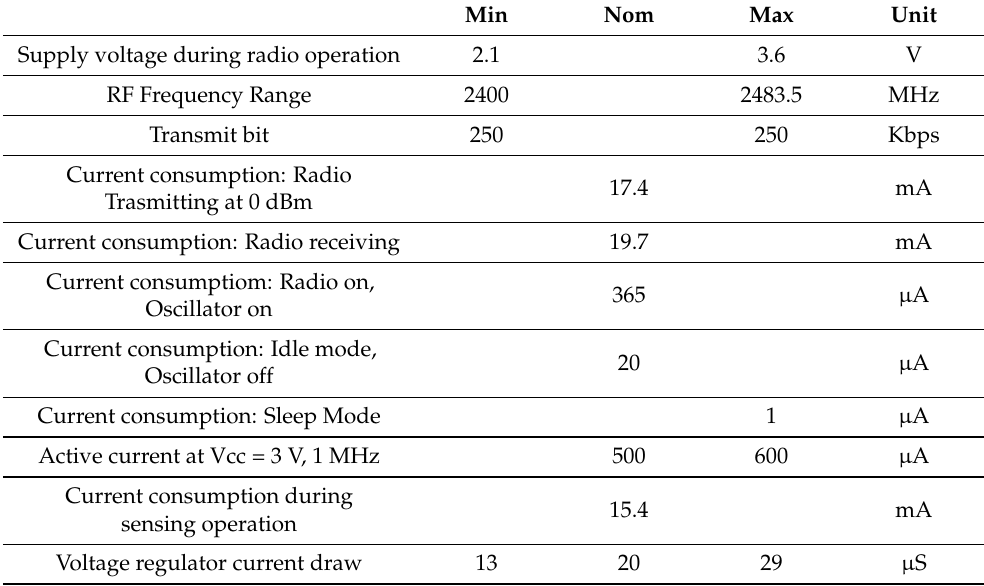
Table 1. Parameters adopted to model a IWSAN node in simulation